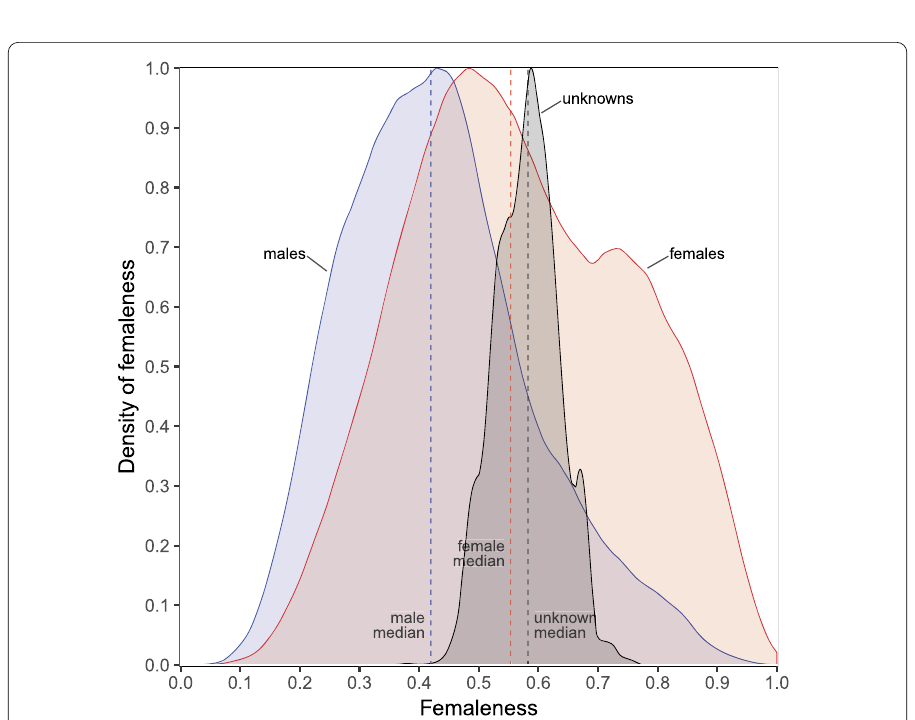
Figure 5 The probability density of femaleness for males, females, and unknown gender. Males have a median femaleness of 0.42, females 0.55, and the highest is unknown gender, with a median femaleness of 0.58. This indicates that users who do not reveal their gender are either females, or males with a decidedly female-like behavioral profile. Users with unknown gender also show the narrowest range of femaleness (0.32 to 0.76; compared to males: 0.07 to 0.96; and females: 0.06 to